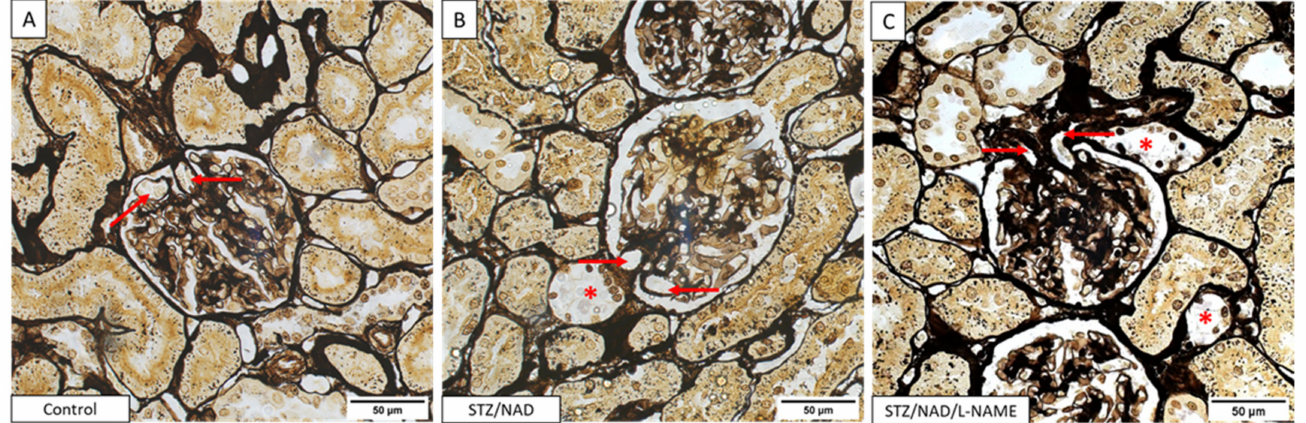
Figure 8. Jones methenamine silver-stained renal sections of a control ( A ), STZ/NAD ( B ), and STZ/NAD/L-NAME ( C ) rat after 12 weeks. The glomerulus exhibited hyalinosis of both the afferent and the efferent (arrow) arterioles in the STZ/NAD/L-NAME diabetic rats. Tubular epithelial cell injury (asterisk) was also